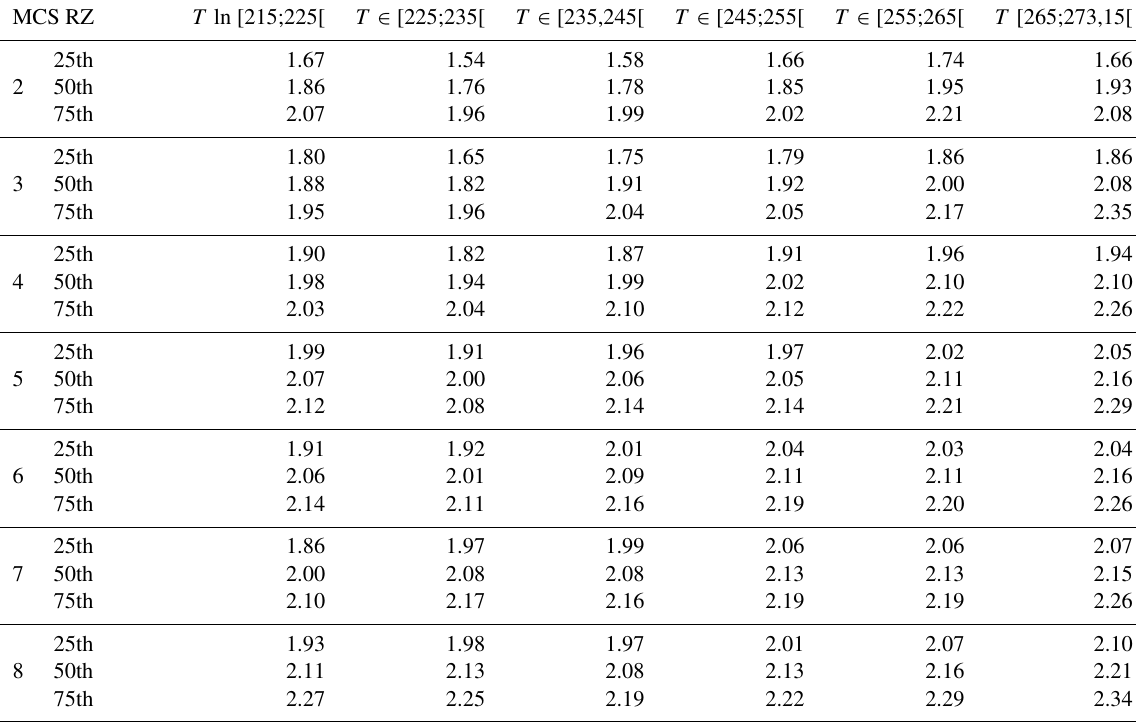
Table C8. Exponent of mass–size relationship β (no dimension) (Fig. 13).